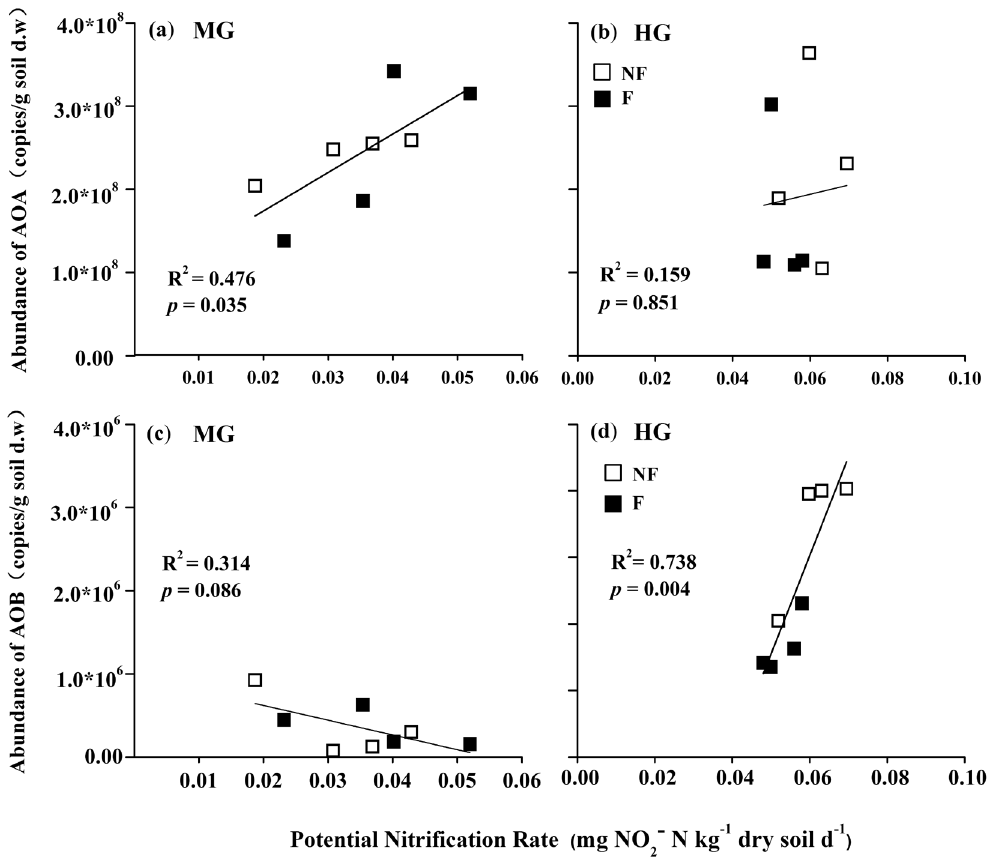
Figure 3. Relationships between potential nitrification rate (PNR) and the amoA gene copy numbers of AOA ( a,b ) and AOB ( c,d ) indifferent treatments. MG moderately grazed site, HG heavily grazed site, NF non- fenced, F fenced treatment. Single asterisk and double asterisk denote the significance at p < 0.05 and p < 0.01,